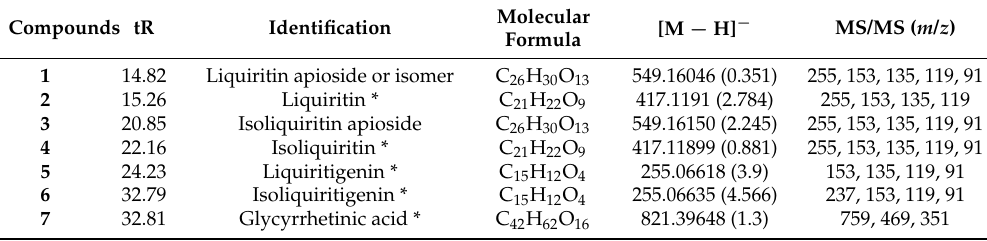
Table 2. Quantification of compounds in licorice aqueous extract by HPLC. Compounds